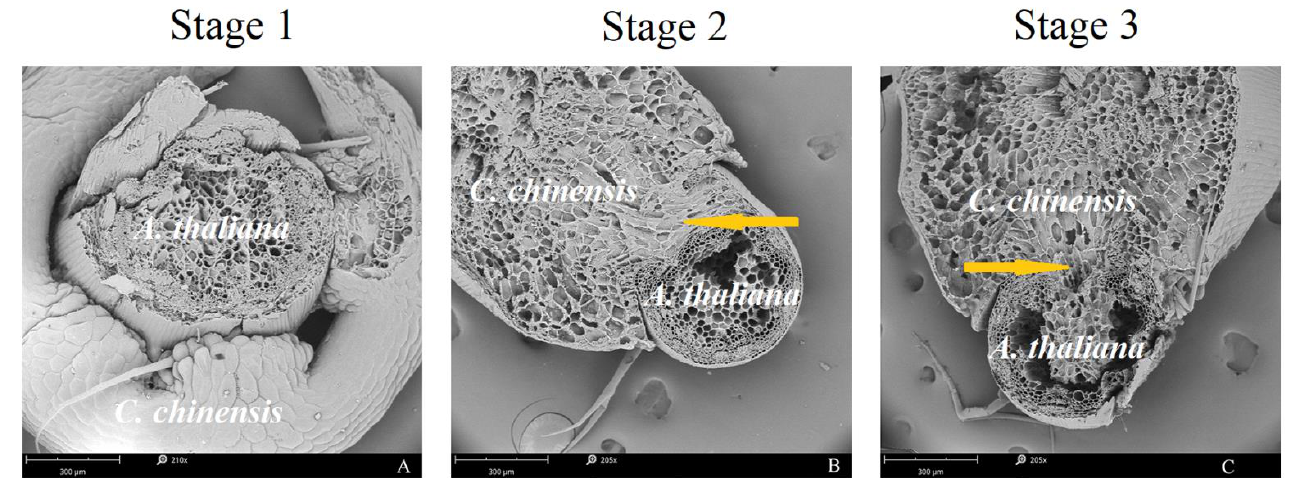
Figure 3. Scanning electron microscope images of haustorial invasion in Arabidopsis thaliana at dif- ferent stages under continuous irradiation at R/FR = 0.1 ratio. ( A ): R/FR = 0.1, 210 × , stage 1; ( B ): R/FR = 0.1, 205 × , stage 2; ( C ): R/FR = 0.1, 205 × , stage 3. The yellow arrow indicates haustorium structure.